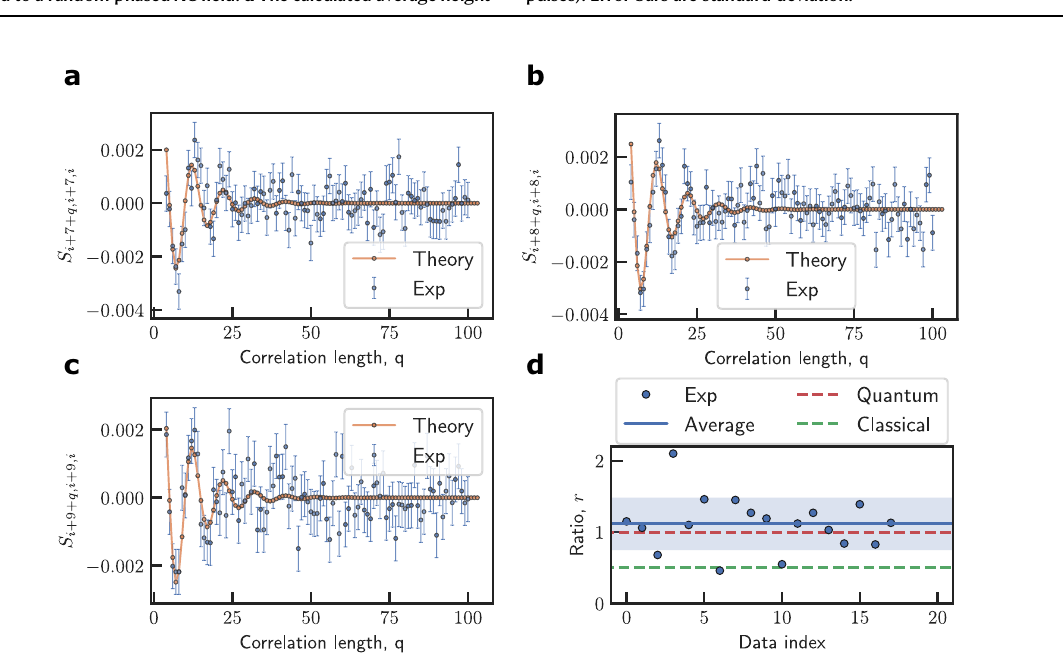
(curve) of the eight peaks at (0, ± ν 0 ), (± ν 0 , 0), ±( ν 0 , 2 ν 0 ), or ±(2 ν 0 , ν 0 ) relative to (cid:5) (cid:4) ν ν ofanNVcenterspin thoseat±( ν 0 , − ν 0 )asafunctionofthenumberofuniformlycouplednuclearspins. ij , jk The symbols are experimental values (green is from Fig. 3a and blue is from Sup- (cid:4) (cid:5) ν ν of an NV plementary Fig. S12, measured with a different number of dynamical decoupling ij , jk pulses). Error bars are standard deviation.